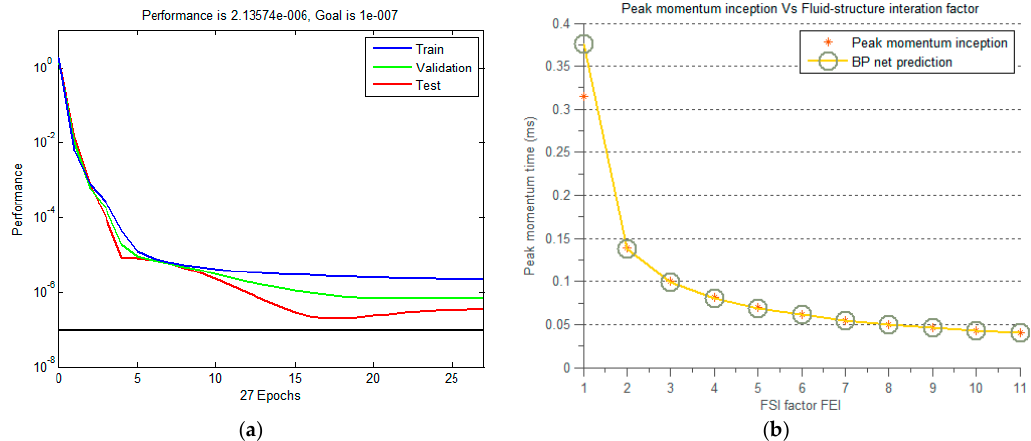
Figure 8. Training process performance curve ( a ) and comparison of the BP neural network prediction with the analytical results ( b ).